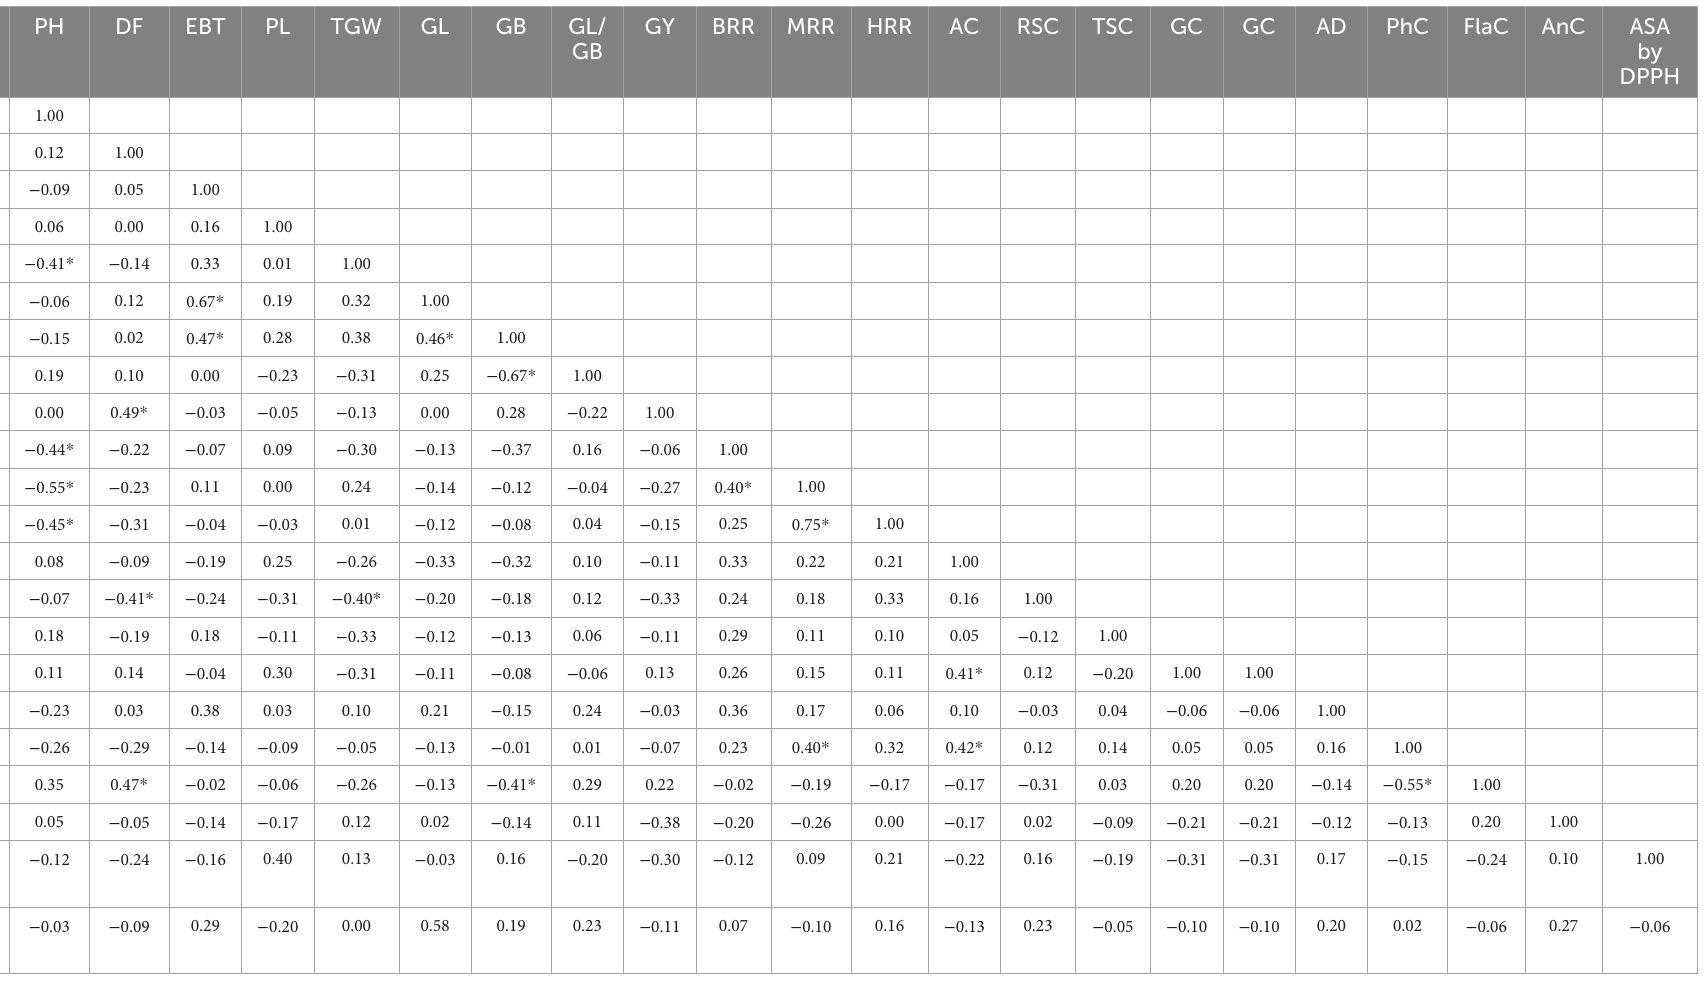
TABLE 3 Pearson’s correlation coefficients among morphological and biochemical traits in C14-8